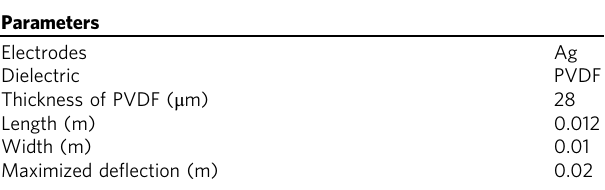
Table 4 Experimental parameters of PVDF- fi lm without packaging Parameters